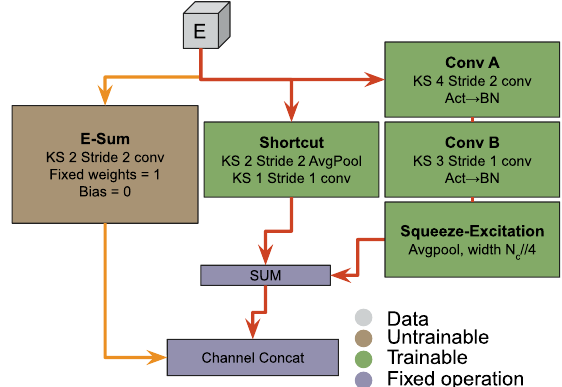
Prior to using the discrete-energy testing-data to com- pute the resolution, the continuous-energy validation dataset is finely binned in true energy, allowing us to compute an approximation of the resolution at the central energy of the bin (computed as the median true-energy of muons in the bin).